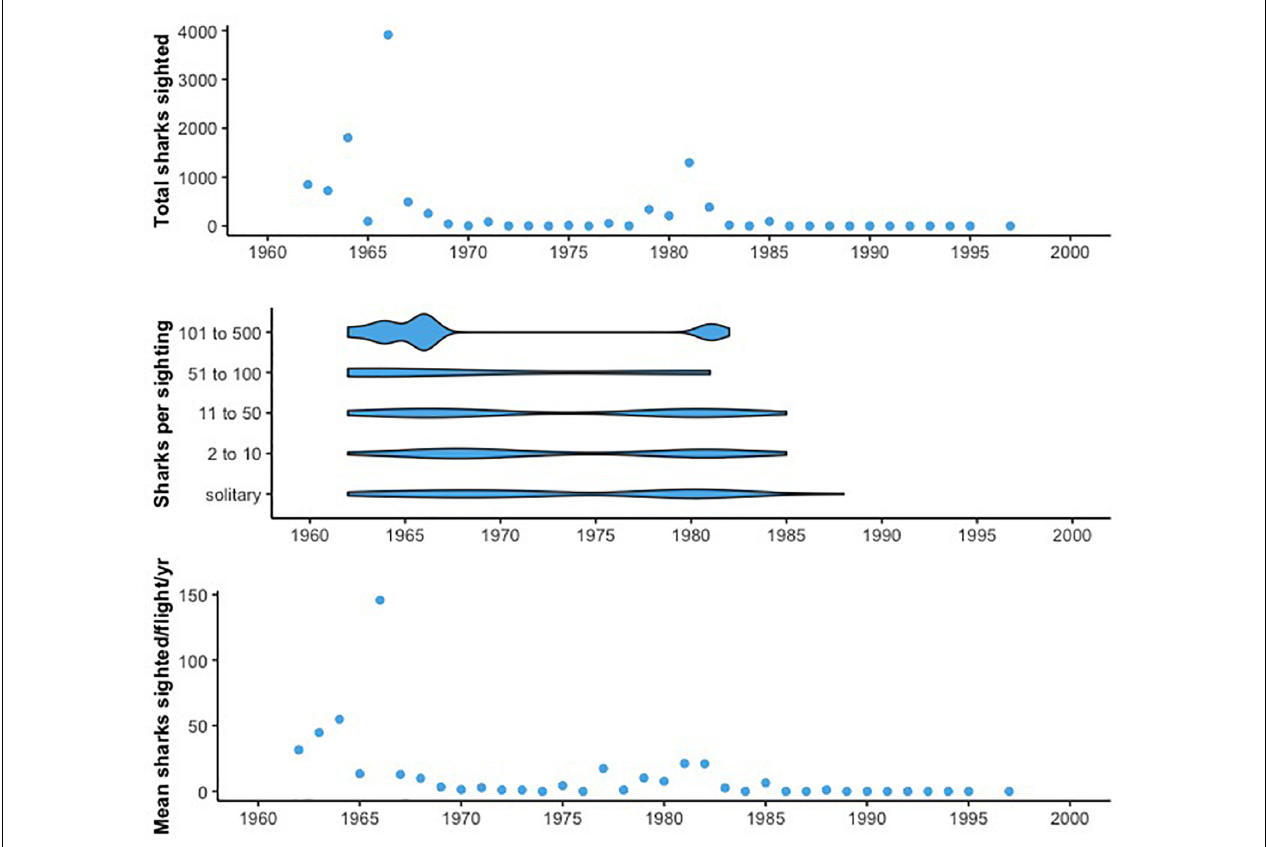
FIGURE 2 | (Top) The total number of sharks sighted based on flights conducted each year in the systematic survey. Peaks in sightings are evident from 1962 to 1985, with few sightings after that time. (Middle) Number of sharks per sighting in the systematic survey data, with each sightings report binned according to the size of the aggregation (solitary individuals, 2–10, 11–50, 51–100, and 101–500). Larger aggregations are present primarily prior to 1983, with smaller groups of sharks reported after that year. (Bottom) Mean number of sharks sighted per flight per year during the systematic survey period, showing similar trends to the total number of sharks sighted each year but accounting for variation in the number of flights